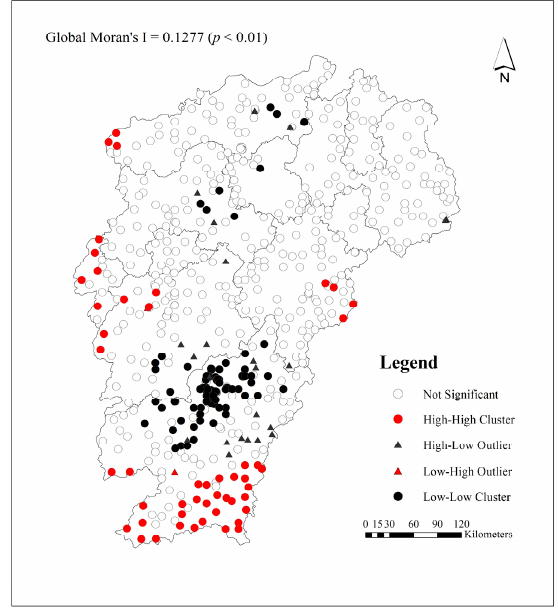
Figure 5. Map of spatial clusters and spatial outliers in vegetation carbon density (including tree, understory vegetation and litter layers) in Pinus massoniana forest in the Jiangxi Province.